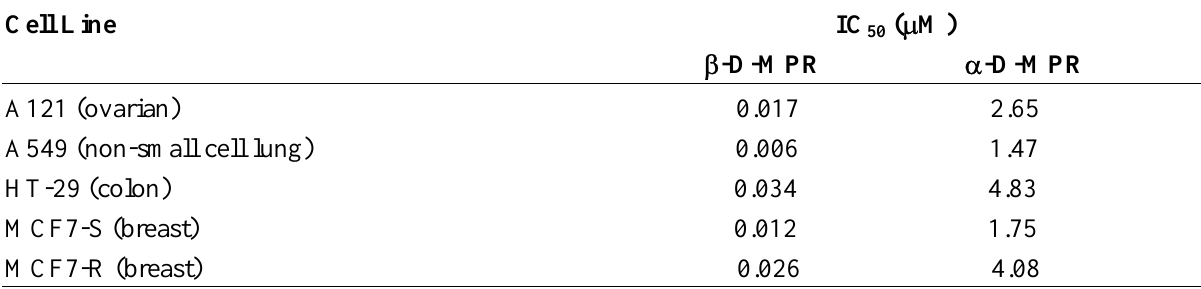
Table 1. Effects of α -D-MPR and β -D-MPR on in vitro g rowth of human tumor cells at 72